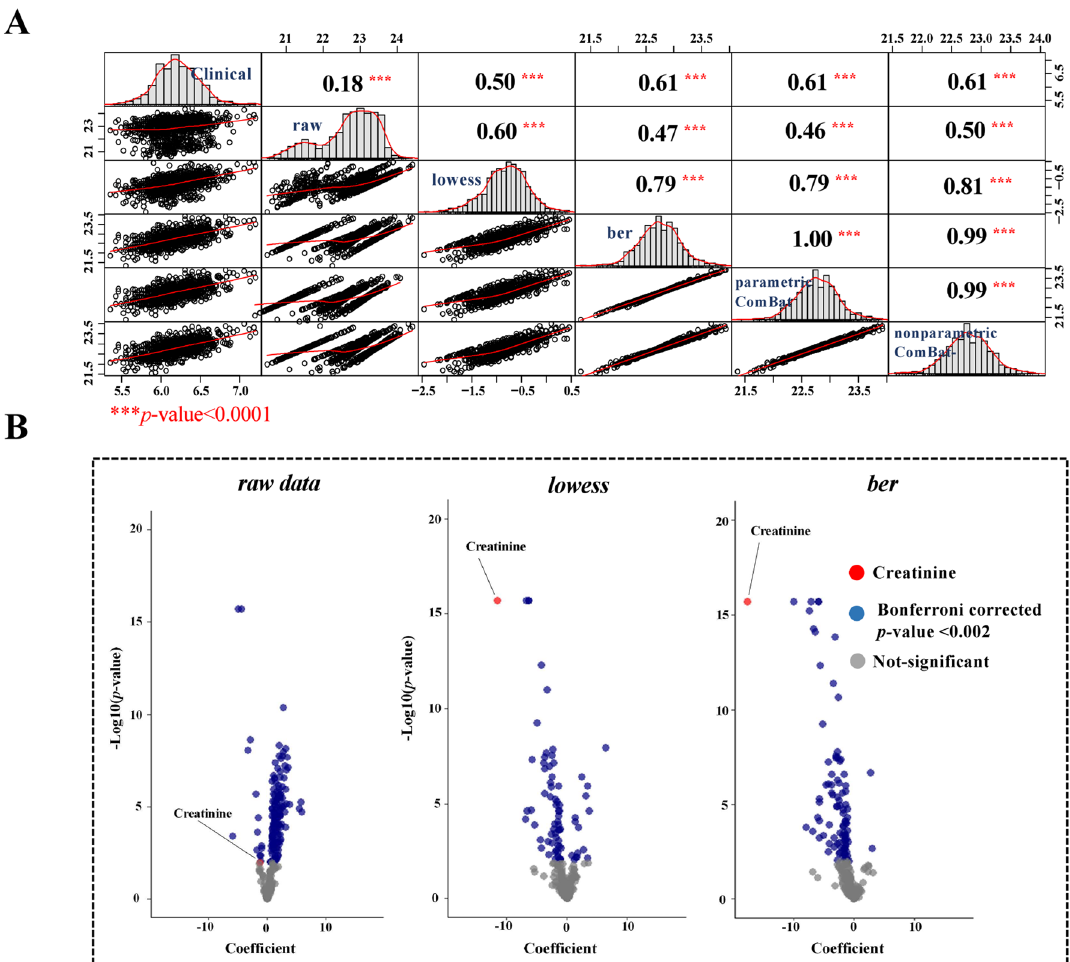
Figure 3. Impact of batch effect correction in LC–MS targeted metabolomics analysis of the SKIPOGH study on downstream differential analysis. Pearson correlation between levels of creatinine, as measured in clinical tests with those measured in LC–MS metabolomics analysis, before or after batch effect correction ( A ). The correlation increases from 0.18 in the raw data, to 0.5 in the lowess -corrected data, to the maximum of 0.61 in the data corrected via statistical models ( ber , parametric and nonpararmetic ComBat ). *** indicates p -value < 0.001. ( B ) Association of CKD-EPI and metabolite levels fails in detecting significant association with creatinine levels in raw data, while this expected association is observed in both lowess - and ber -corrected datasets. The model is adjusted by age and sex. Bonferroni corrected p -value were considered as significant